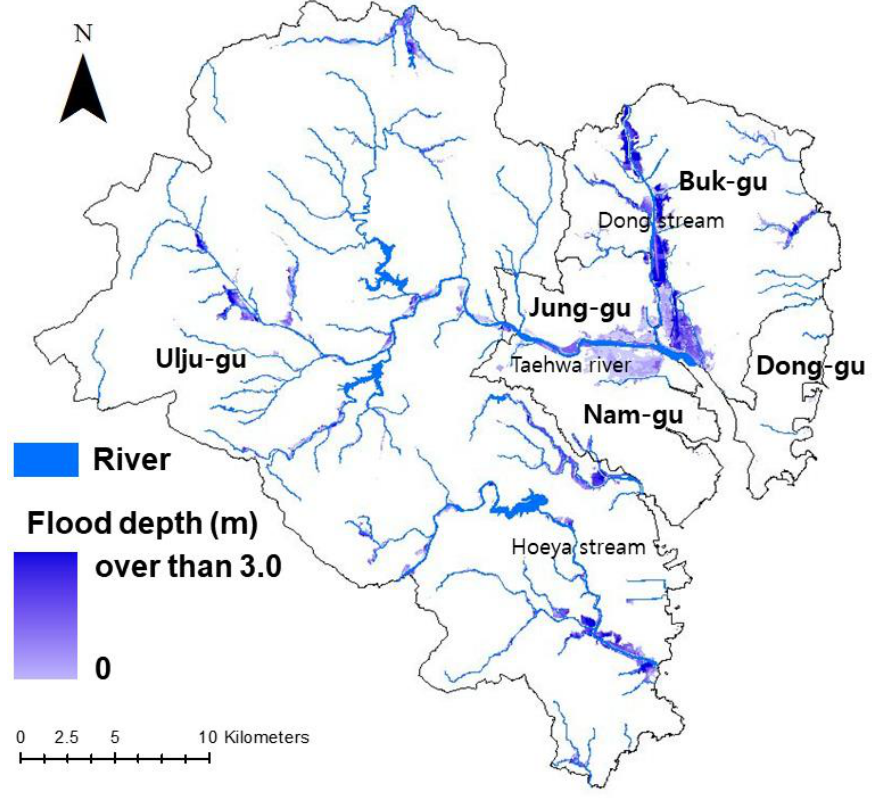
Figure 7. Hazard for urban